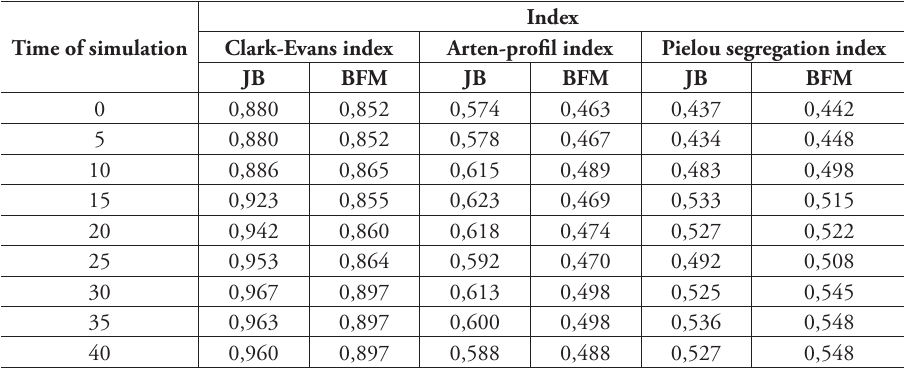
Table 2. Indices prediction on the Jeleni Bucina (JB) and Bucina pod Frantiskovou Myslivnou (BFM) study sites after spontaneous